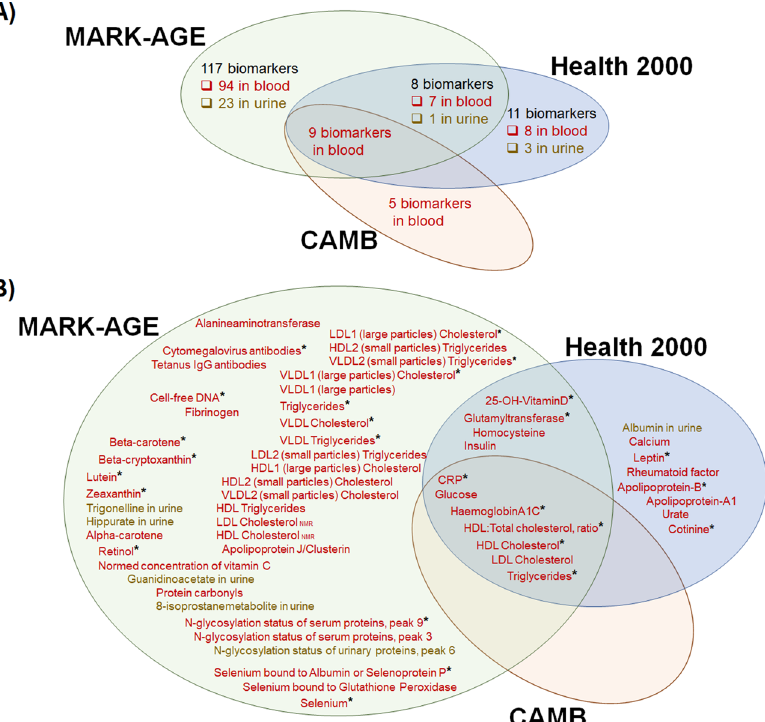
Figure 1. A summary of ( A ) the number of biomarkers in the analysis in the three data sets and ( B) biomarkers associated with SRH, adjusted for age and gender (Model i, in the full samples). Sample types are indicated with colors: red = blood, yellow = urine, and * symbol indicates that association was significant also after the adjustment for diseases and physical functioning (Model ii, in the full